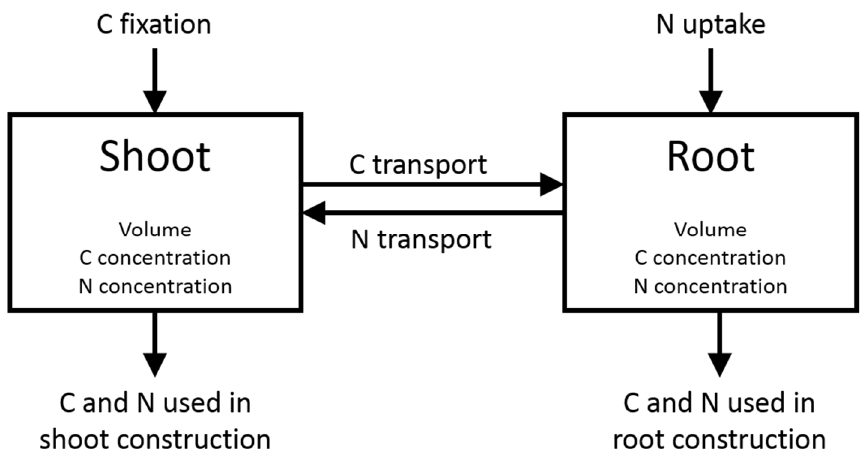
Figure 1. Two pool model of shoot and root growth. C and N status in each pool influences the volume of the pool. Adapted from